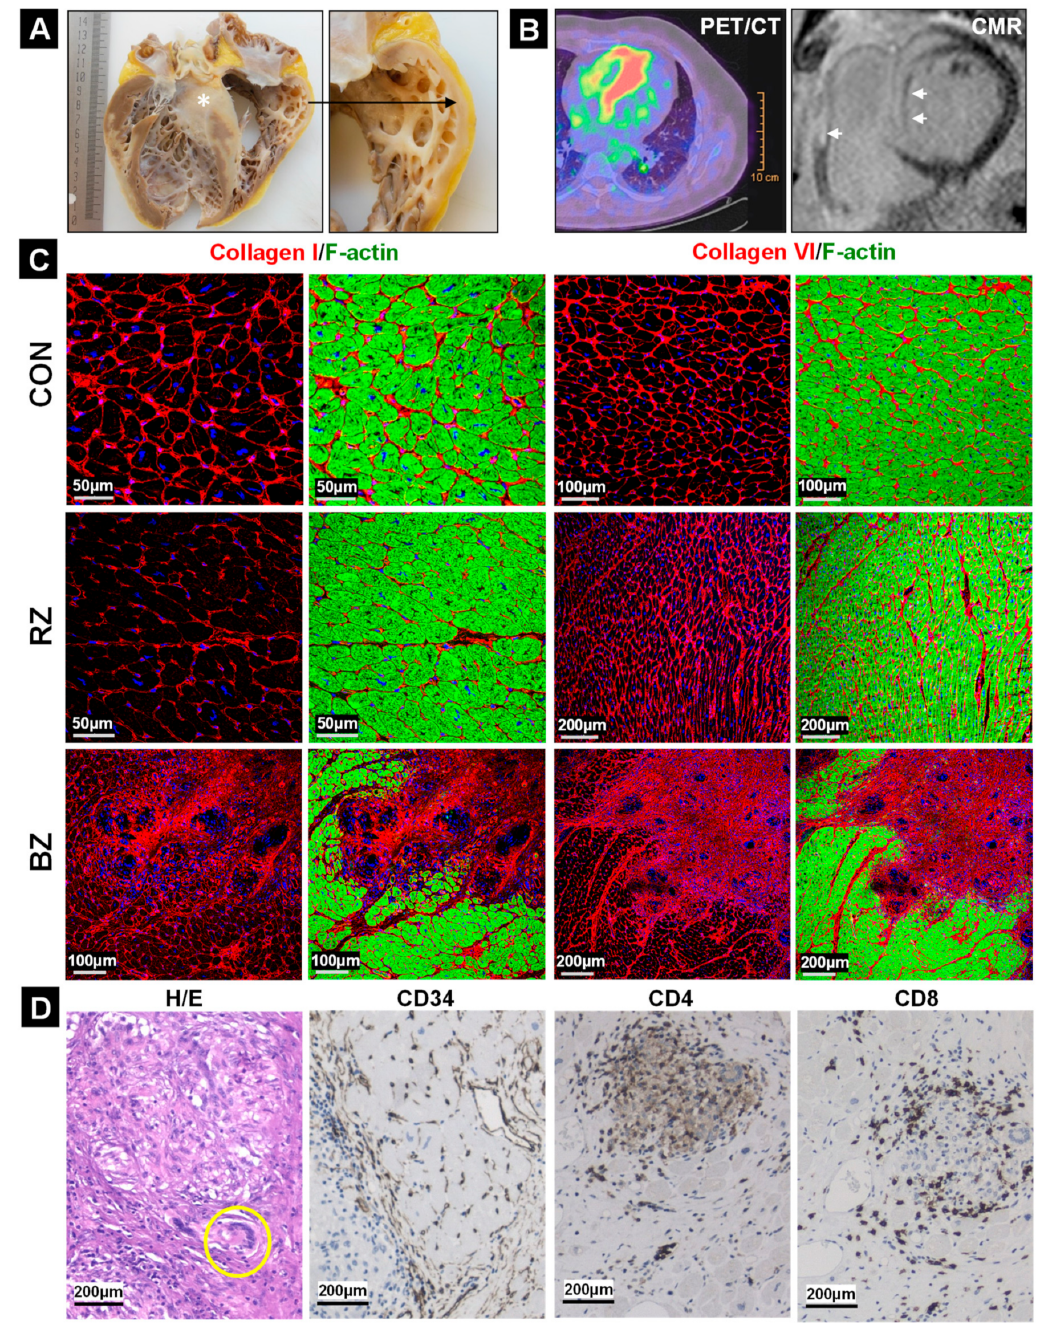
Figure 1. Loss of muscle mass, fibrosis and accumulation of immune cells are features of cardiac granuloma. ( A ) The macroscopic image of an explanted heart with cardiac sarcoidosis shows strong loss of muscle structure, wall thinning (magnified image indicated by a black long arrow) and massive fibrosis (white star). ( B ) 18 F-FDG PET/CT image of a patient with cardiac sarcoidosis. Uptake of fluoroglucose indicates local inflammation in the heart and is shown in red. Cardiac magnetic resonance imaging (CMR) reveals marked septal and ventricular late enhancement (white arrows). ( C ) Staining of collagen I and VI mark fibrotic areas. For comparison, the control (CON) tissue is shown. Border zone (BZ) is the myocardial area surrounding the granuloma and remote zone (RZ) is the myocardium distant to granuloma. The nuclei are stained blue with DAPI. ( D ) Hematoxylin and eosin staining (H/E) display epithelioid granulomata with “horseshoe” like giant cells (yellow circle). The CD34 immunohistochemical image marks capillaries around the granuloma. Immunohistochemistry reveals CD4 and CD8 positive T cells mainly surrounding the granuloma. See also the Figure 2 fluorescence